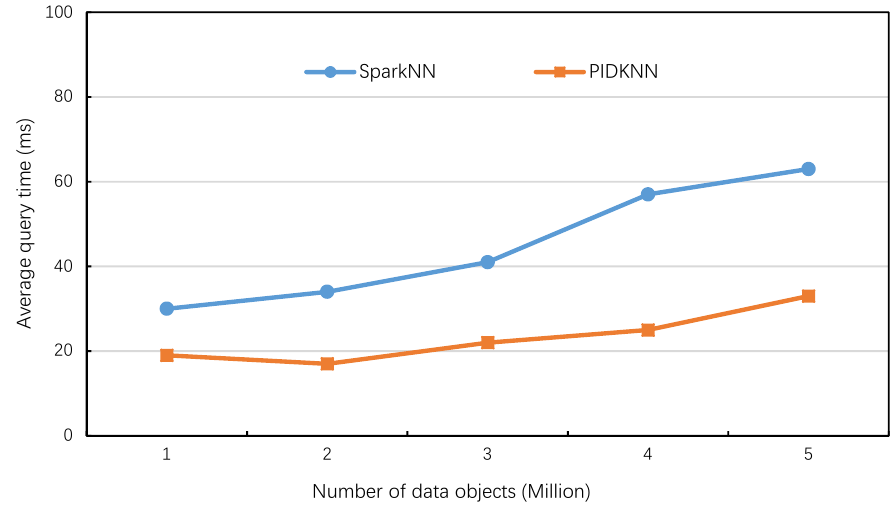
Figure 11. Average query time vs. number of data objects.